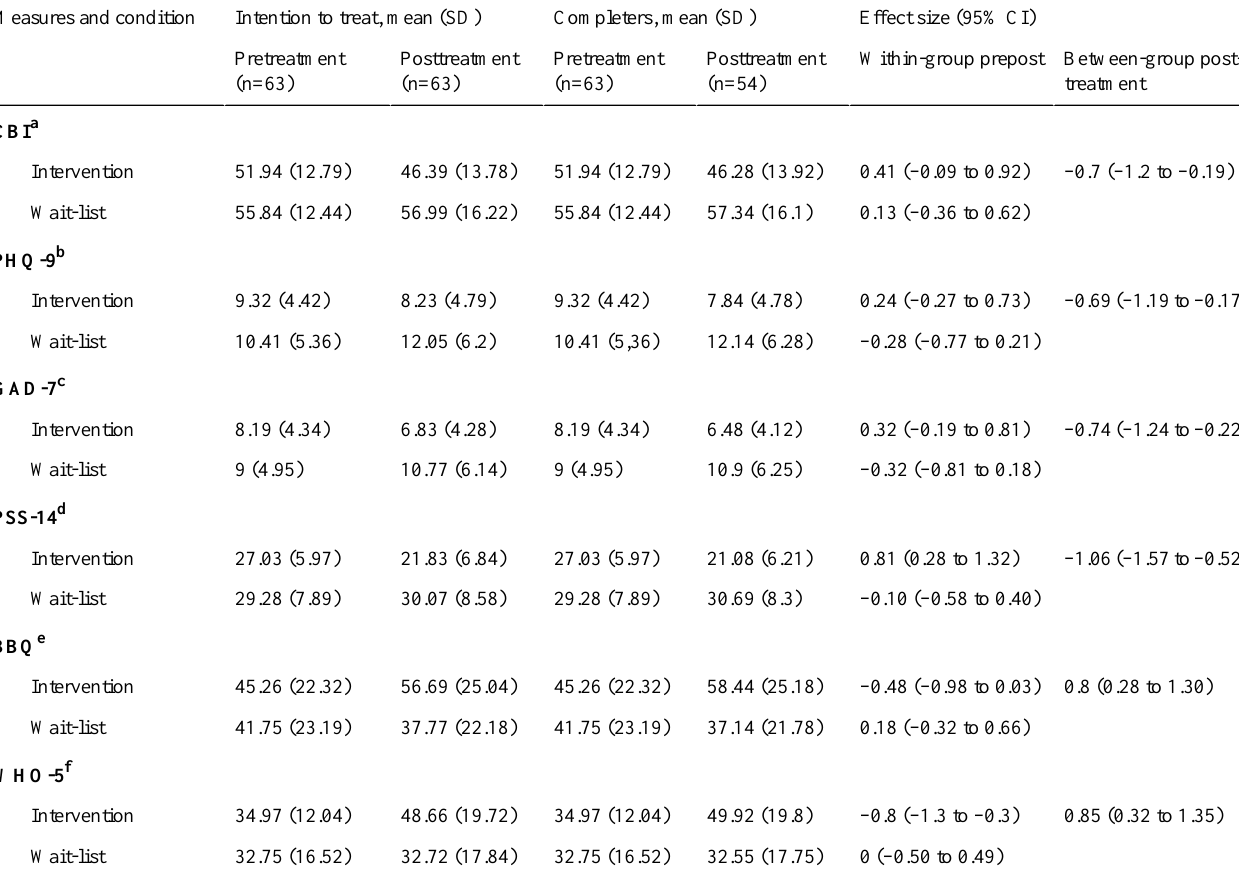
Table 3. Means, standard deviations, and effect sizes (Cohen d ) with confidence